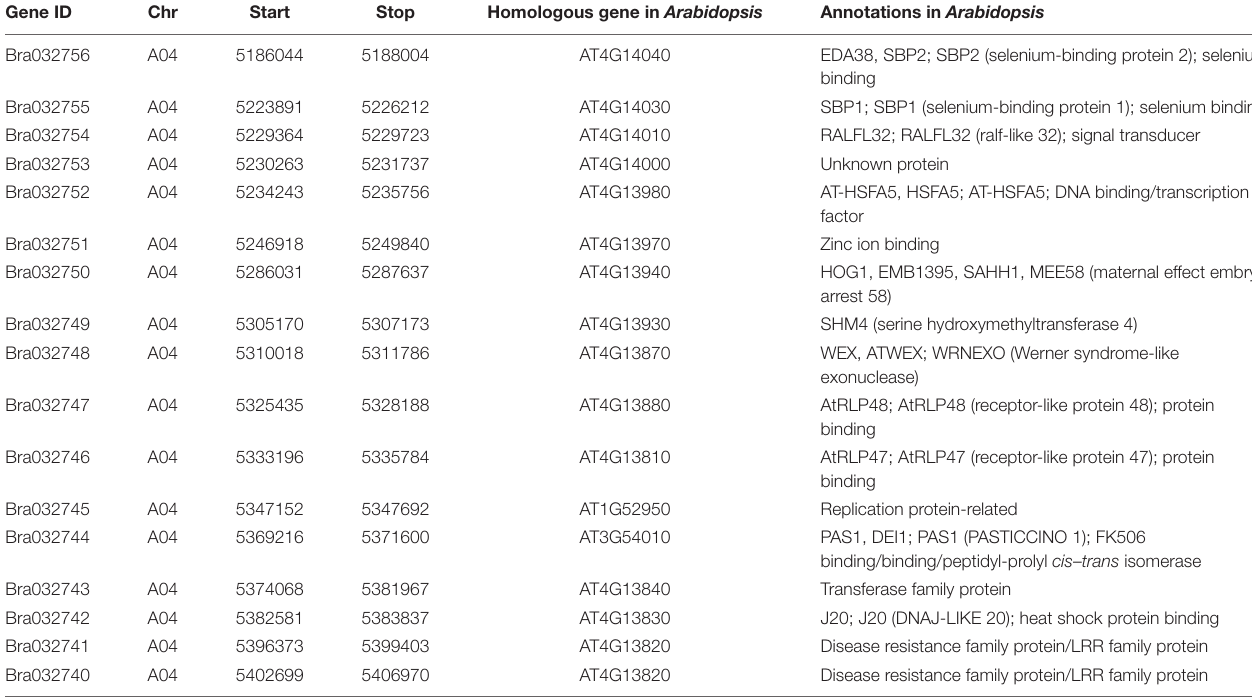
TABLE 1 | Sixteen annotated genes in the 160 kb region of Bra-DM04 .